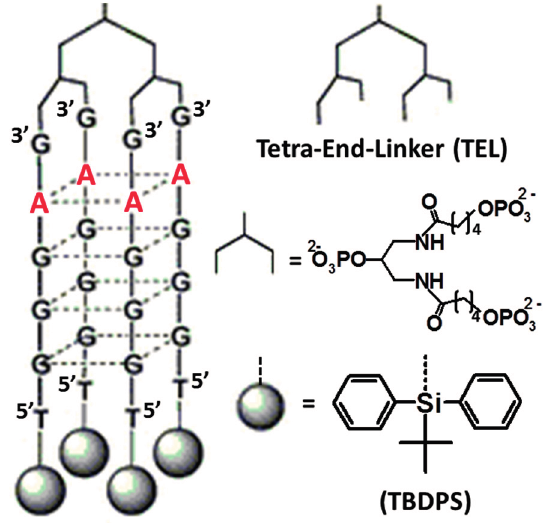
Figure 3. Schematic representation of the best unimolecular G4-forming